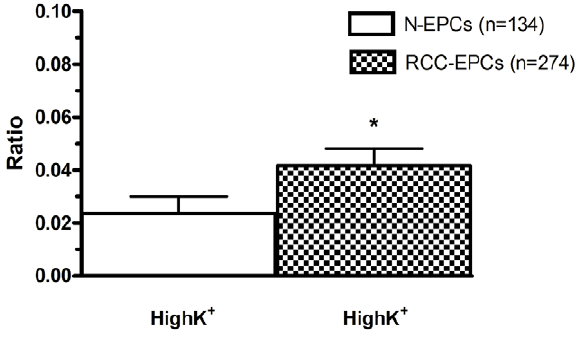
Figure 2. The amplitude of store-operated Ca 2 + entry in endothelial progenitor cells isolated from patients affected by renal cellular carcinoma is still higher in the presence of a high-K + extracellular solution. Mean 6 SE of CPA-evoked SOCE in N- EPCs and RCC-EPCs bathed in presence of an extracellular solution containing 100 mM KCl to clamp V M at the same value in both cell types. CPA was applied at 10 m M. The asterisk indicates p , 0.05 (p=0.039).